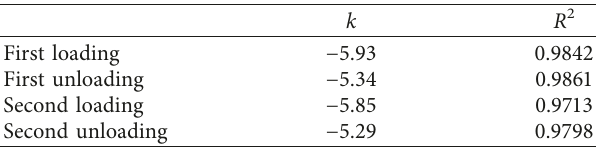
Figure 13: Recognition index curve for loading and unloading process. Table 4: Parameters of the fitting